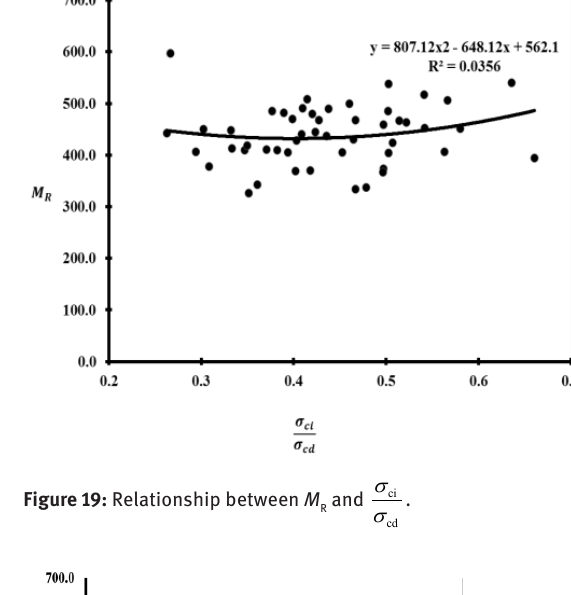
and e Fig. 15. Relationship between M and a, max . and  R R cd e and 𝜎𝜎 𝑐𝑐𝑐𝑐 R cd 𝜀𝜀 𝑎𝑎 (cid:3) 𝑚𝑚𝑎𝑎𝑚𝑚 𝑀𝑀 𝑅𝑅 𝜎𝜎 𝑐𝑐 Figure 18: Relationship between M Fig. 18. Relationship between M 𝜀𝜀 𝑐𝑐𝑐𝑐 initiation strain ( 